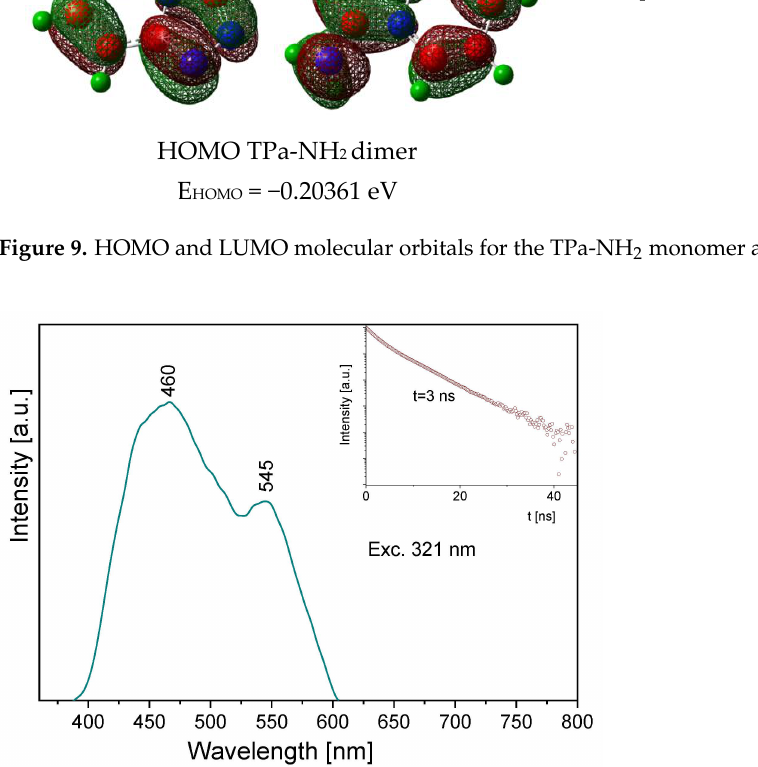
Figure 10. The emission spectrum of the TPa-NH 2 molecule. Inserts show the emission lifetime for the TPa-NH 2 molecule excited at 321 nm. Comparing the theoretical data with the UV-Vis and emission spectra of the studied compound, another explanation of its electron properties can be proposed. The lumi- nescence of the title compound was observed in the range 460 – 545 nm. It clearly shifted into red in relation to the S 0 → S 1 absorption transition, calculated at 326 nm and observed